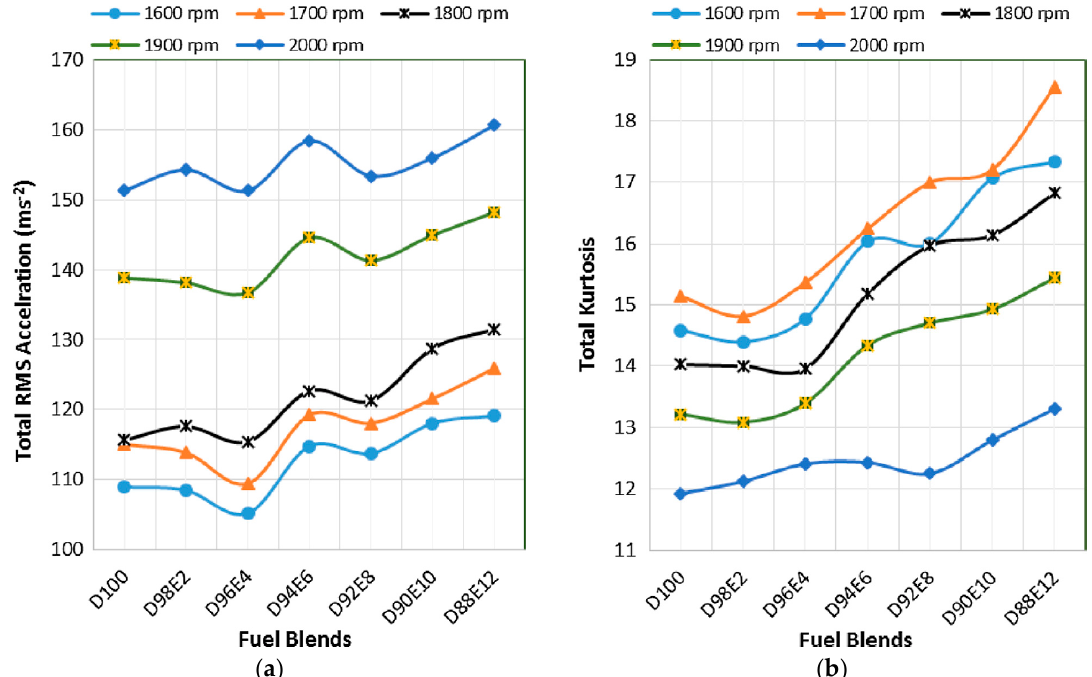
Figure 23. ( a ) Resultant acceleration diagram for different fuel blends; ( b ) resultant kurtosis chart for different fuel blends [85]. Figures are reprinted with permission from publisher.